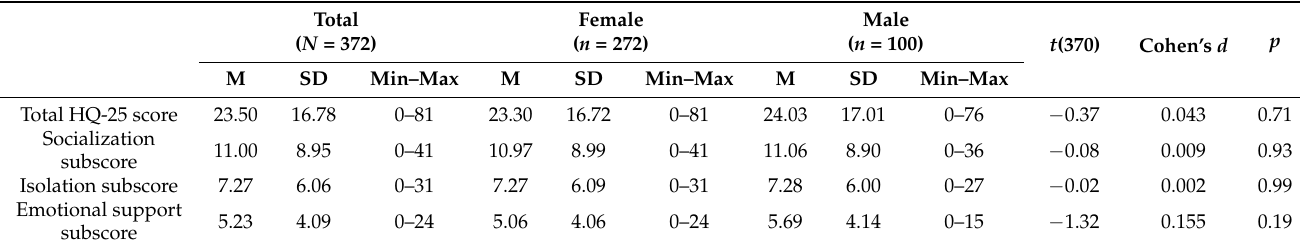
Table 3. Statistics for the HQ-25 according to gender.